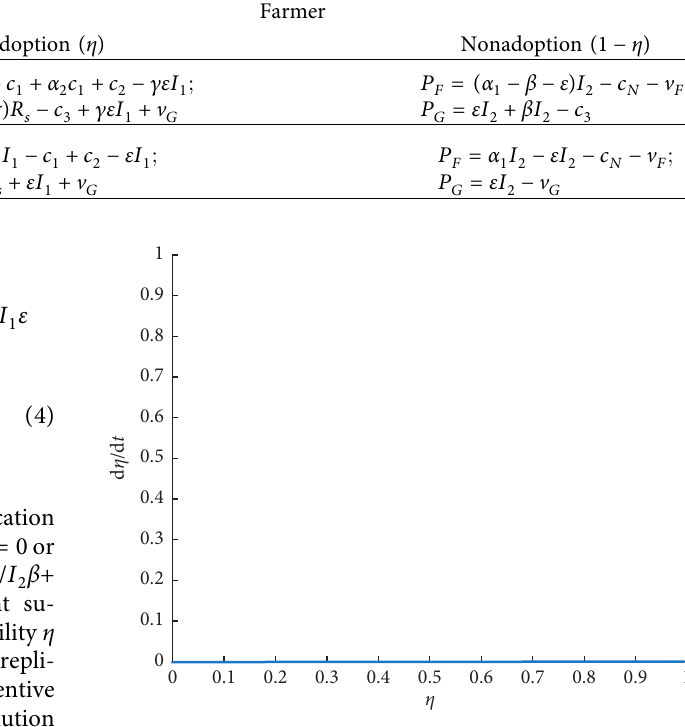
Figure 3: The evolution phase diagram of μ � μ ∗ .